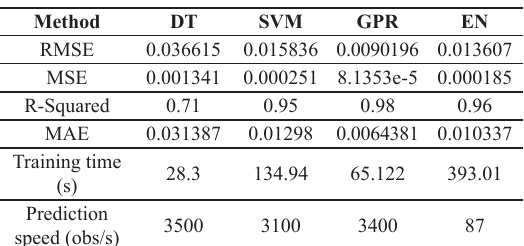
Table 2. Statistical analysis of the OMLR methods during the training